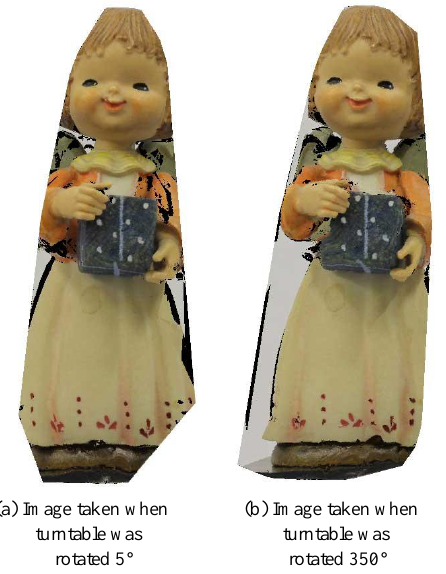
Figure 14. Difference images that were constructed using search